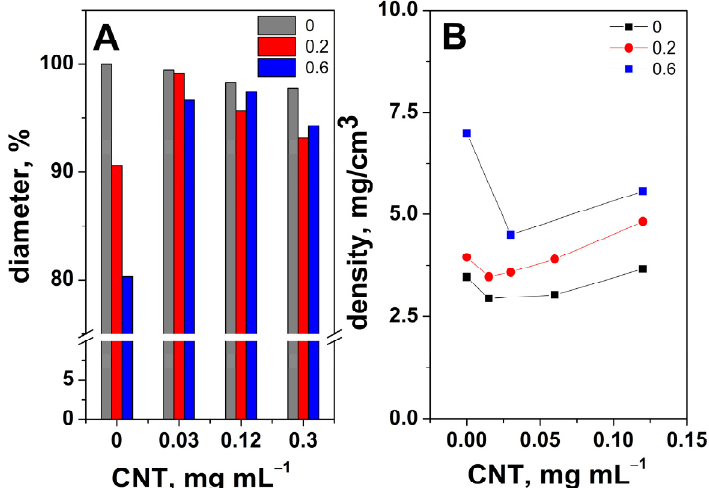
Figure 1. Evolution of diameter ( A ) and density ( B ) for the PAMAM-modified (mg mL − 1 ) aerogels with CNT content.